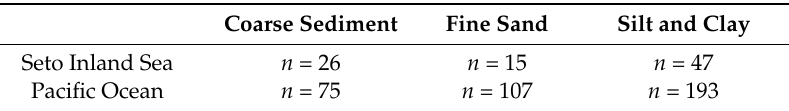
Table C2. The two-way layout for